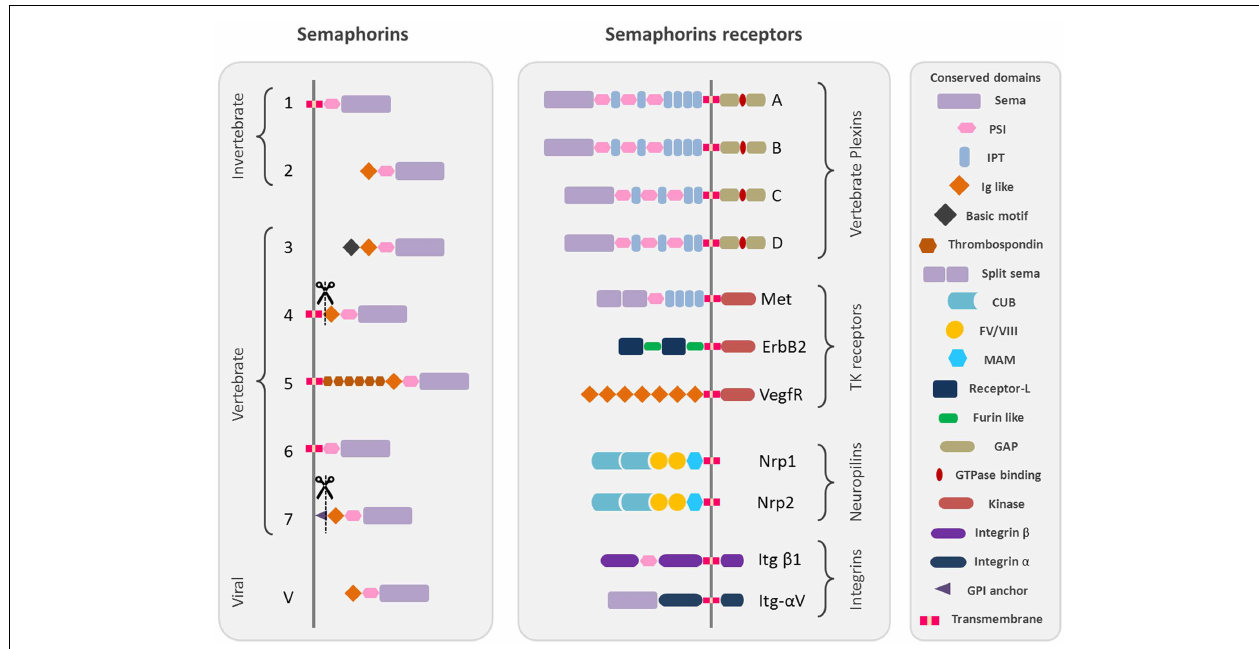
semaphorin, and integrin) and immunoglobulin (Ig)-like domains.The structural conserved domains are drawn in different shapes and colors as indicated in the figure. Domains abbreviations: PSI, plexin semaphorin integrin; IPT, Ig-like PlexinTranscription factors; Ig-like, immunoglobulin like; CUB, complement C1r/C1s, Uegf, Bmp1; FV/VIII, coagulation factorV/VIII homology like; MAM, meprin like; GPI,